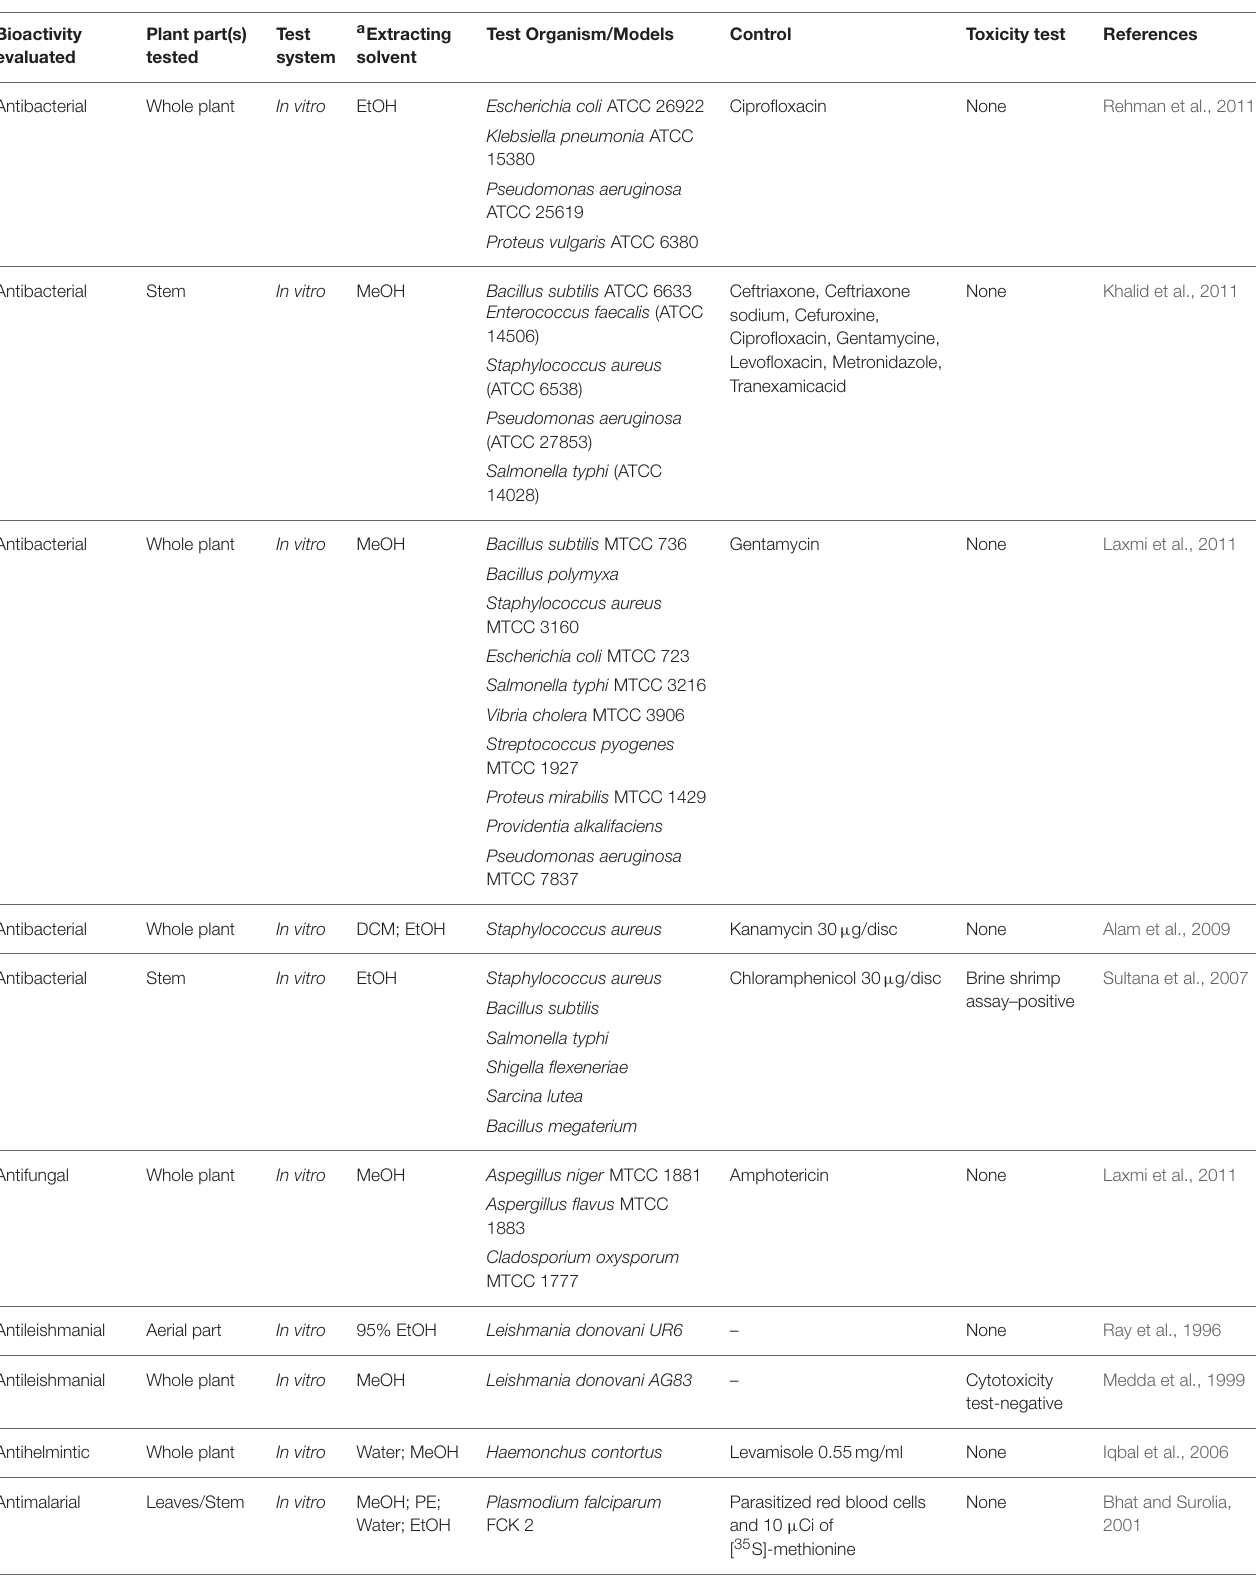
TABLE 2 | Evaluation of the biological activities of Swertia chirayita